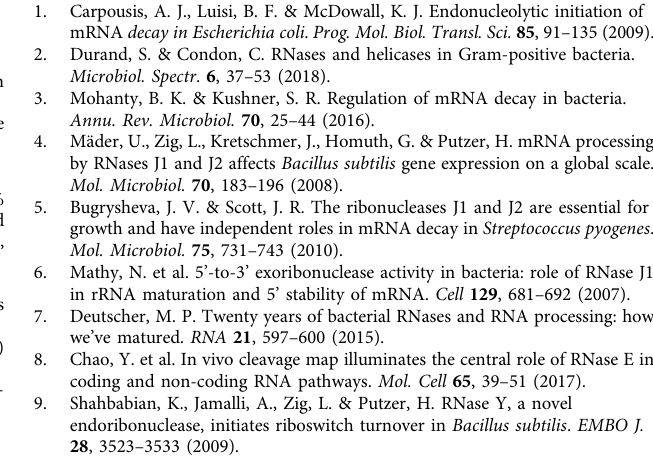
Figs. 7b and 3f are published (https://doi.org/10.1073/pnas.1809663115) and are available at NCBI under the accession number